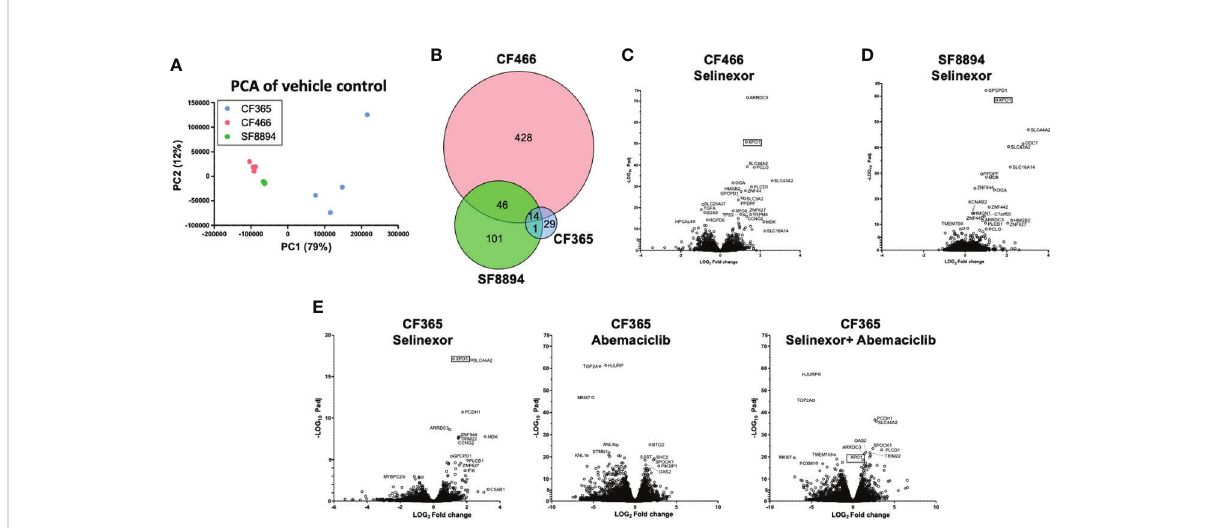
FIGURE 4 Differential expression analysis in treated xenografts compared to matched vehicle controls. (A) Principal component analysis (PCA) analysis of gene-level expressions in vehicle treated control tumors for the indicated PDX models. Each dot represents one tumor. (B) Venn diagram indicating the number of genes differentially expressed in selinexor treated tumors compared to match vehicle controls. (C – E) Volcano plots show comparison of all expression of genes between indicated treatment group and vehicle control for CF466 (C) SF8894 (D) and CF365 (E) models. Y-axis is signi fi cance and x-axis is fold change. Top signi fi cant genes are labeled. XPO1 is indicated with a box.